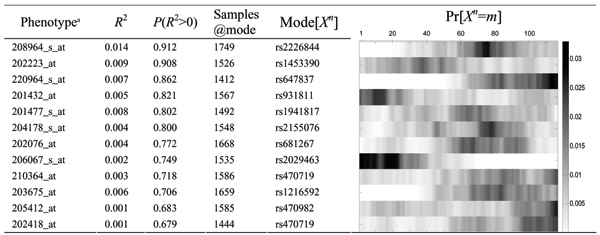
Linkage of residual gene expression variation after association.  Phenotypes ranked by most significant coefficient of determination in the covariance model, the posterior distribution of their locus position Xn, and its mode. The coefficient of determination and its significance are calculated from samples drawn around the mode (10%).